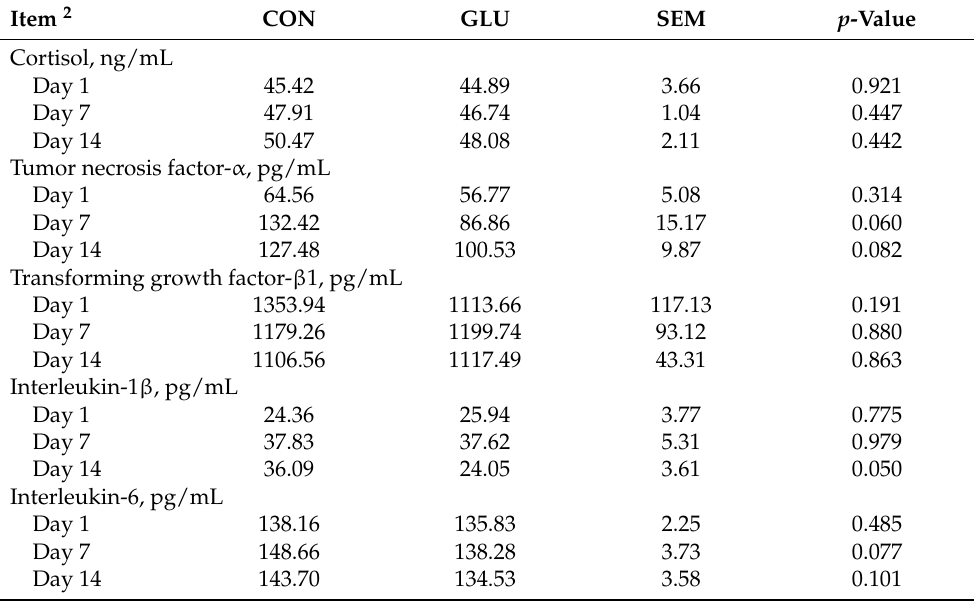
Table 8. Effects of dietary treatments on the alpha diversity of bacteria of weaned pigs 1 .